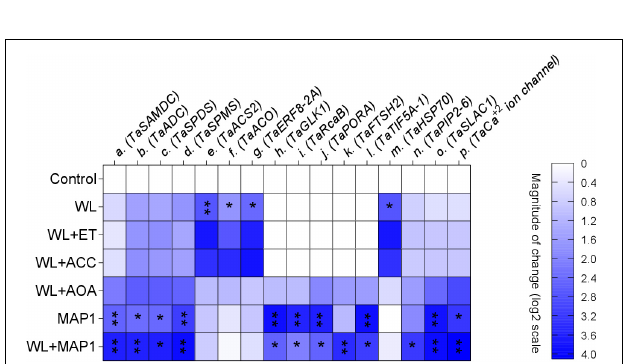
FIGURE 9 | Expression profiling of polyamine biosynthesis genes, ET biosynthesis and signaling genes, photosynthetic activity-related genes, stress-reducing genes, and membrane transporter genes (root and stomatal) by qRT-PCR. Quantitative data represent means ± SD of three independent experiments and at least four technical replicates each. The asterisks indicate a significant change in gene expression compared to untreated control ( ∗ p ≤ 0.05; ∗∗ p ≤ 0.01).